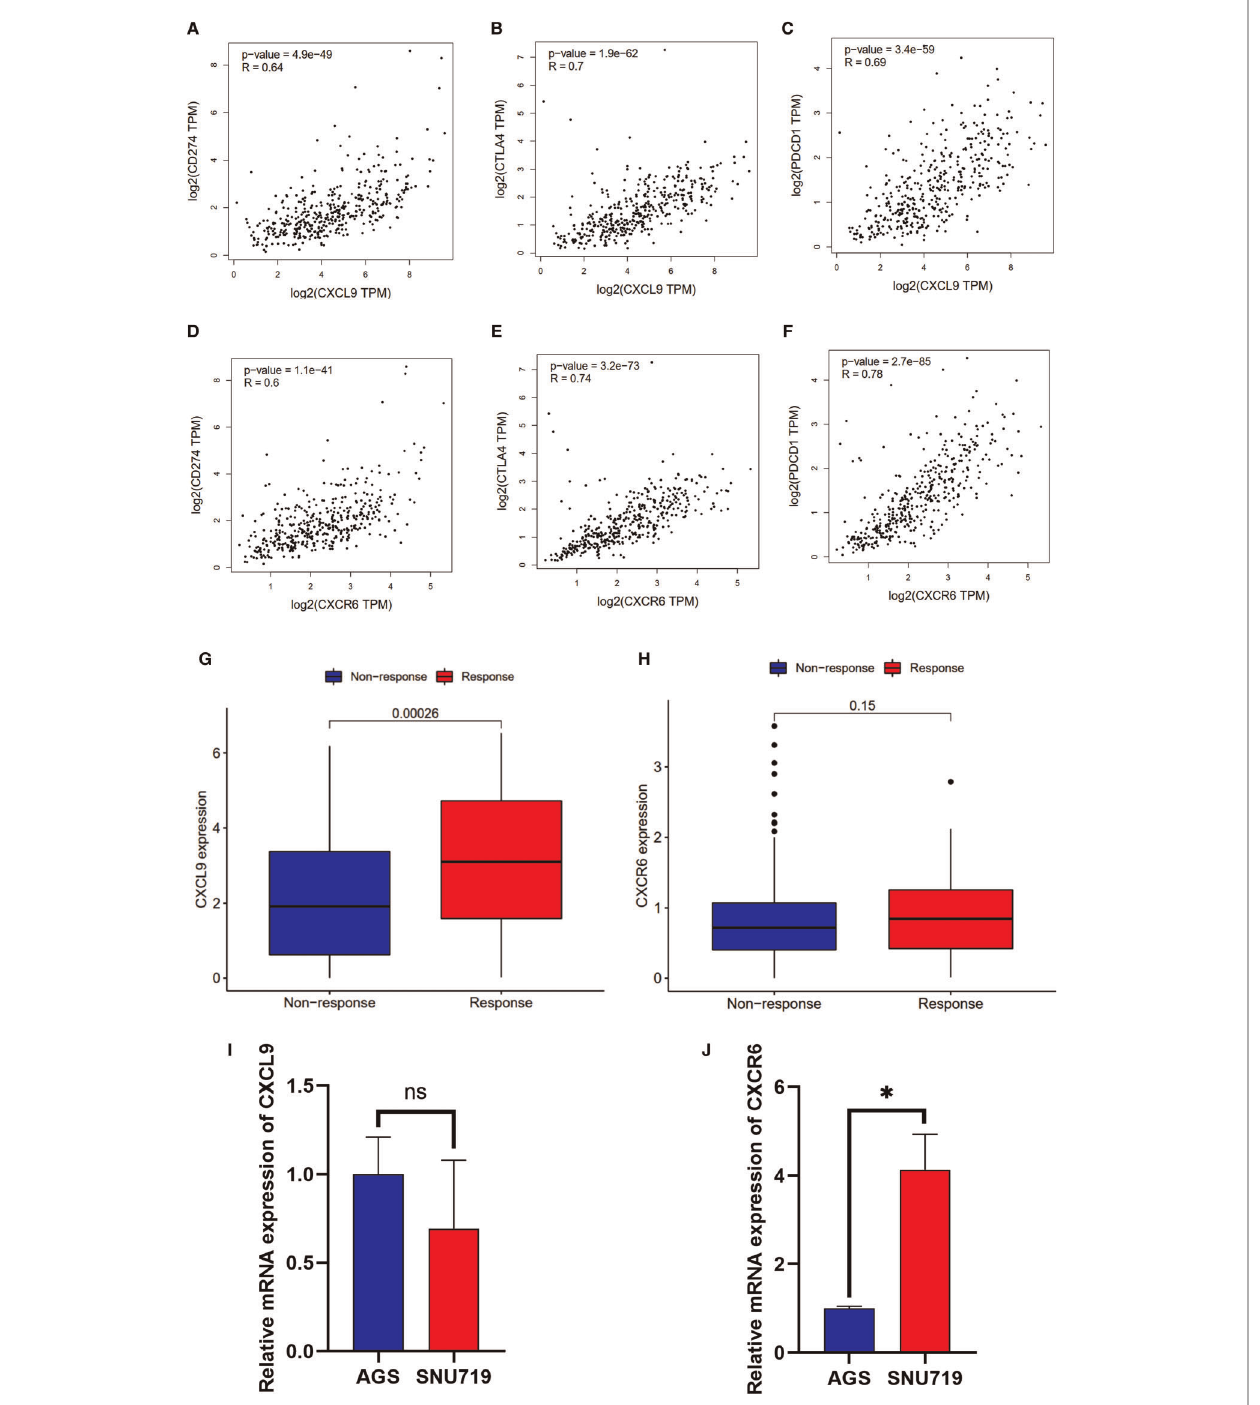
FIGURE 9 | Correlation between the HUB genes with immunotherapy. ( A – F ) Scatter plot showing the correlation of ICPs, CD274(PD-L1), CTLA-4, and PDCD1(PD-1), with the CXCR6 ( A – C ) and CXCL9 ( D – F ) expression (correlation test: Pearson coef fi cient). ( G,H ) CXCR6 and CXCL9 expression with the effect of immunotherapy. ( I,J ) Validation of mRNA expression of CXCL9 and CXCR6 in human EBV-associated gastric cell lines (SNU-719, red) and EBV-negative GC cell lines (AGS,